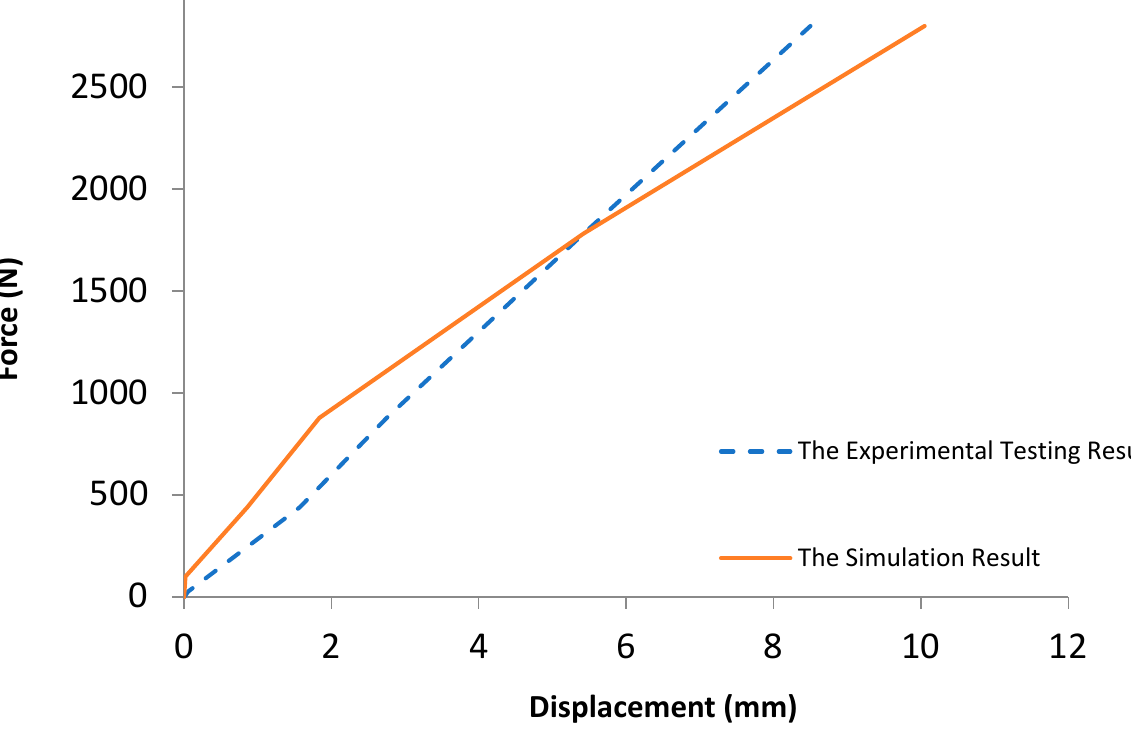
Figure 16. Comparison simulation and experimental of AFSS. The value of the maximum load was set at 1500 N. The displacement was recorded as 4.6 mm from the experimental test. The reason for the significant difference in displace- ment between the FE model (wrapped around the CFRP) and the testing sample is the pores filled around the AF core in the actual beam; however, the solid structure was se- lected for an FE model to simplify it and reduce the calculation time for the simulation results. The failure flexure load of larger AFSS wrapped around CFRP was 2800 N. The same maximum load was applied to the FE model to determine the displacement between the experimental testing sample and FE model. Figure 17 shows that the displacement of the FE model was 10 mm under the 2800 N (peak load obtained by the experimental result) and the testing result is 8.5 mm.